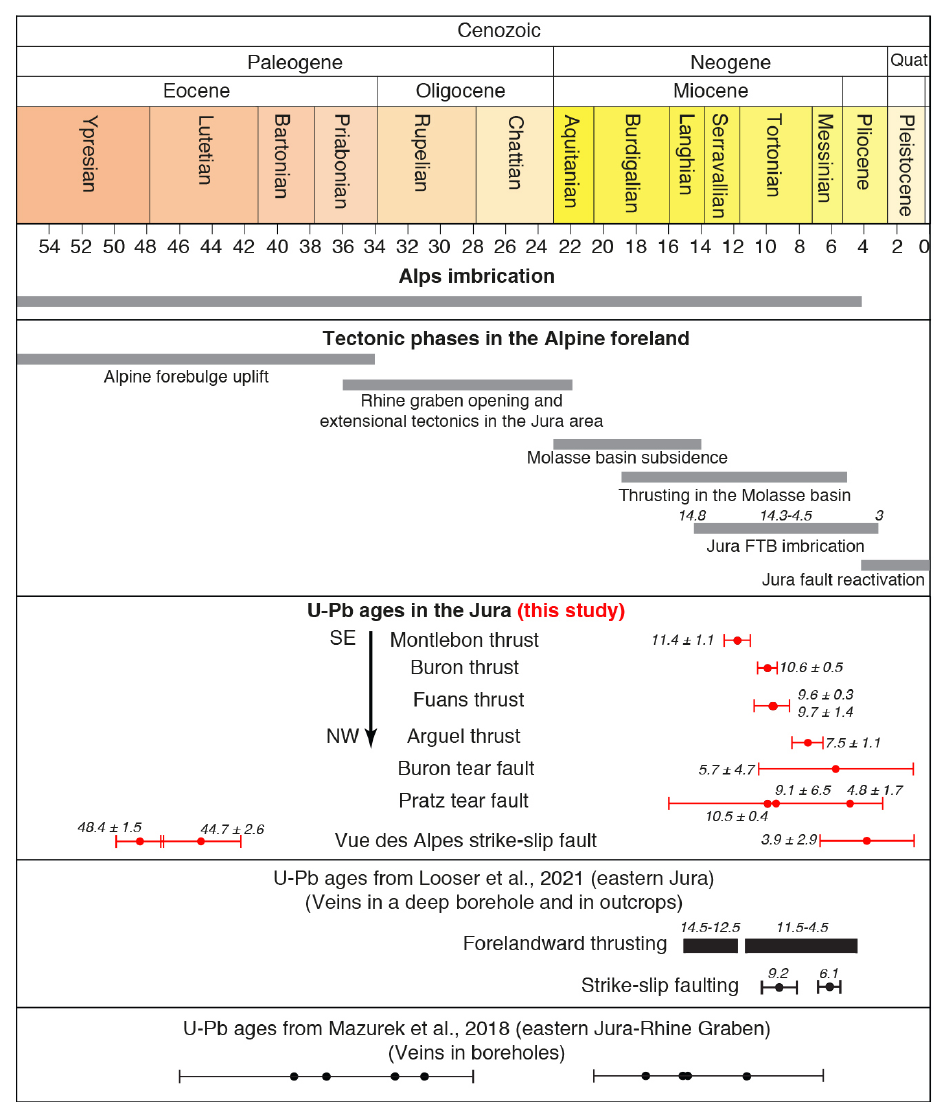
Figure 7. Main tectonic phases in the Alps and in the Alpine foreland. Age constraints shown as grey bars are from Burkhard and Sommaruga (1998), Ustaszewski et al. (2006), Madritsch et al. (2008), Bellahsen et al. (2014), and Von Hagke et al. (2014). For calcite U–Pb data, all uncertainties are represented as 2 σ